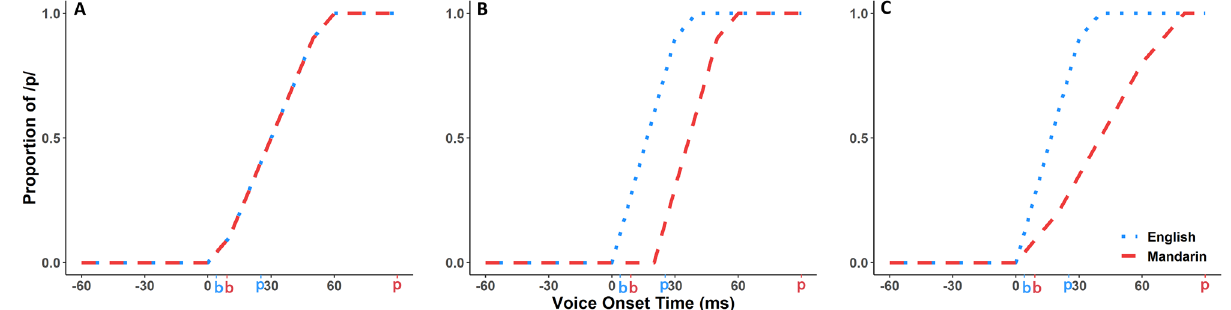
Figure 1. Schematic of three possible models of phoneme perception by bilinguals. Hypothetical identification functions are shown for each of a bilingual’s languages, with prototypical productions for voiced and voiceless stop consonants shown below each model. English = blue; Mandarin = red. ( A ) Unified model of phoneme perception with same slope and threshold for perception in both languages. ( B ) Discrete boundary model of phoneme perception, with different thresholds for each language. ( C ) Discrete slope model of phoneme perception, with different slopes in the identification function for each